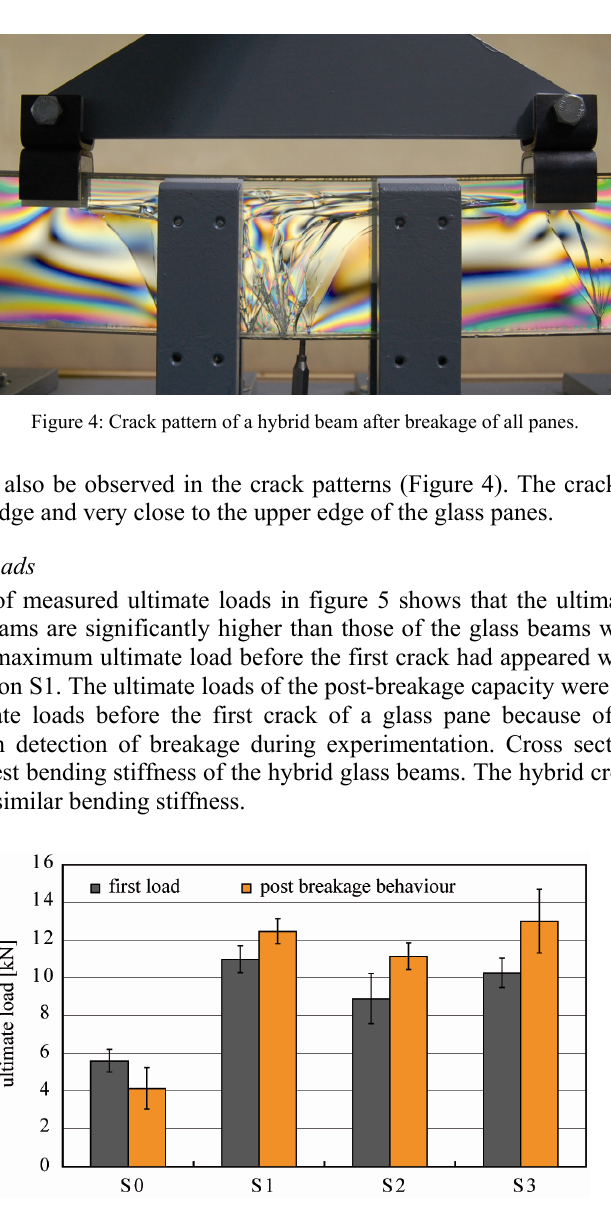
Figure 5: Ultimate load of the hybrid